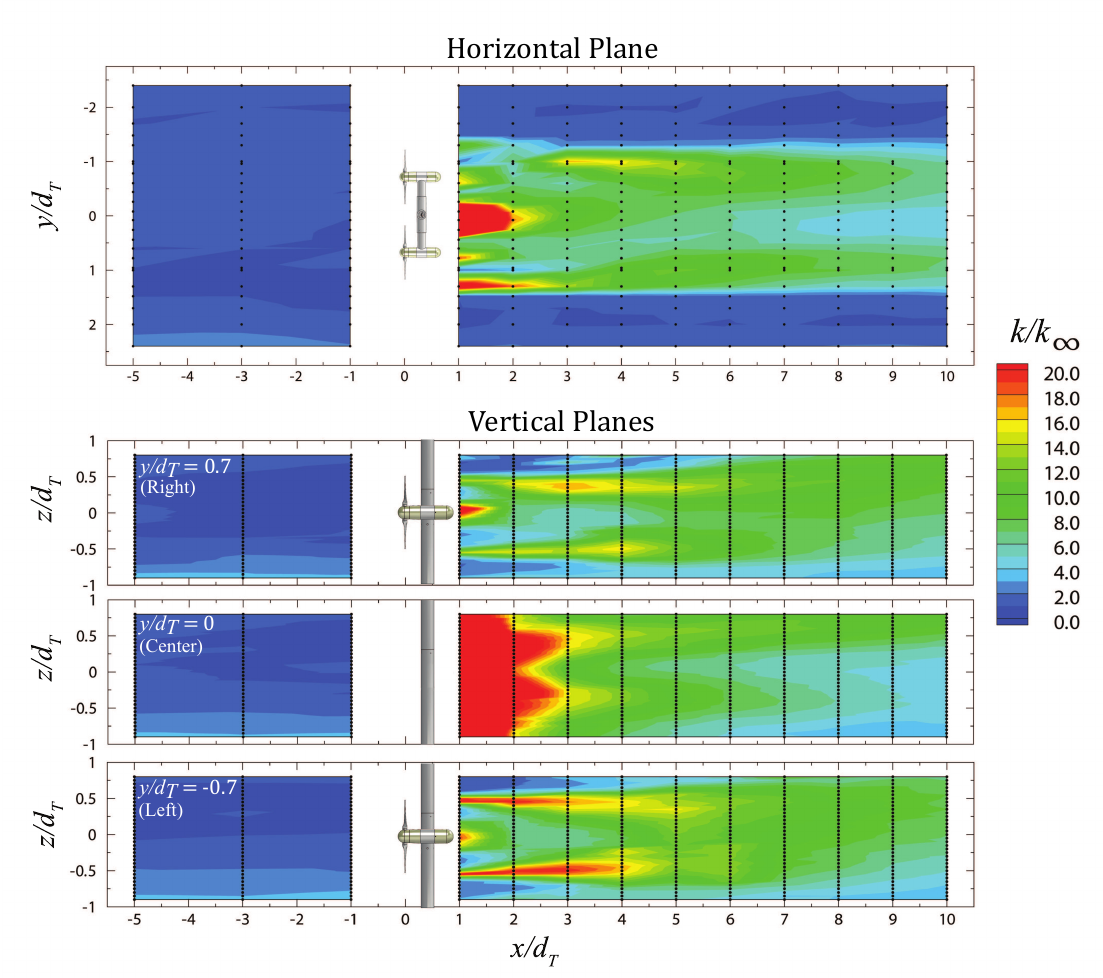
Figure 12. Normalized turbulent kinetic energy, k / k ∞ , horizontal ( xy ) and vertical ( xz ) plane contours upstream and downstream of RM1 in the SAFL Main Channel. Horizontal plane y -axis, y / d T , shows full channel width ( b = 2.75 m). Vertical plane y -axis, z / d T , shows full water depth during the experiment ( h = 1.0 m). Horizontal and vertical dotted black lines indicate actual ADV measurement locations. ADV vertical point spacing ∆ z = 0.025 m ( z / d T = 0.05). Horizontal spacing varied. Measurements collected at λ ≈ 5.1 ( ω = 3.4 rps). Flow is left to right.